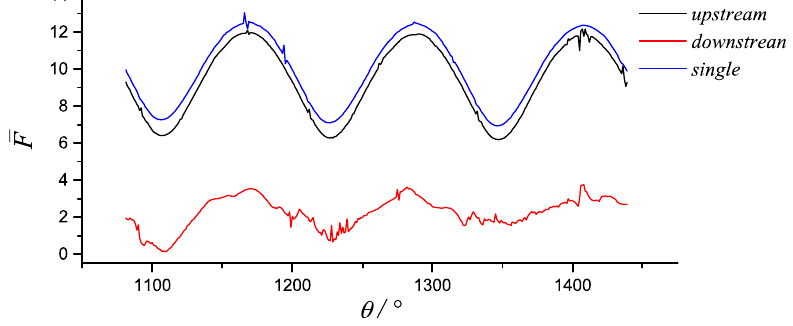
Figure 8. The force of the rotor varies with the azimuthal angle in the case of double turbines in series where Z = 3 and λ = 2.